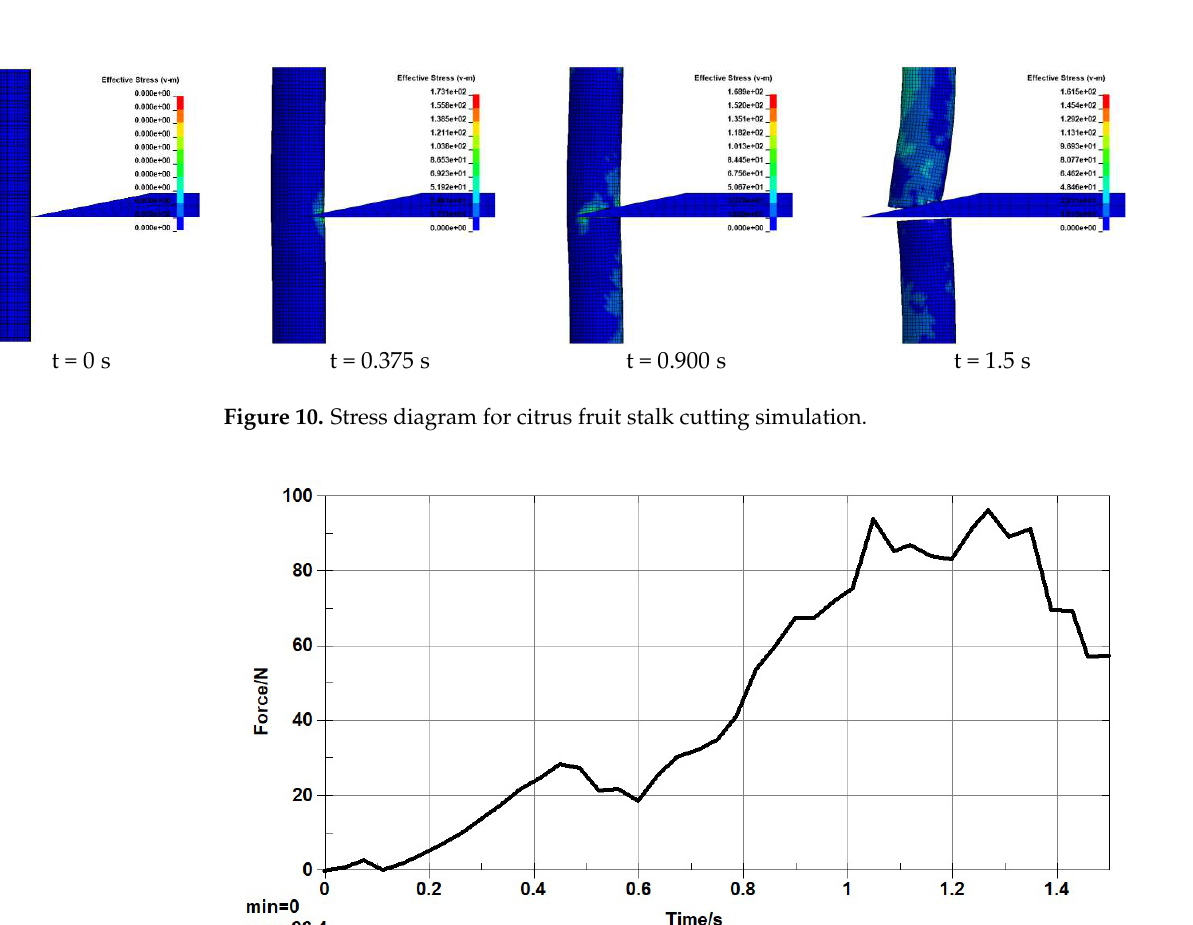
Table 1. Physical characteristics of citrus